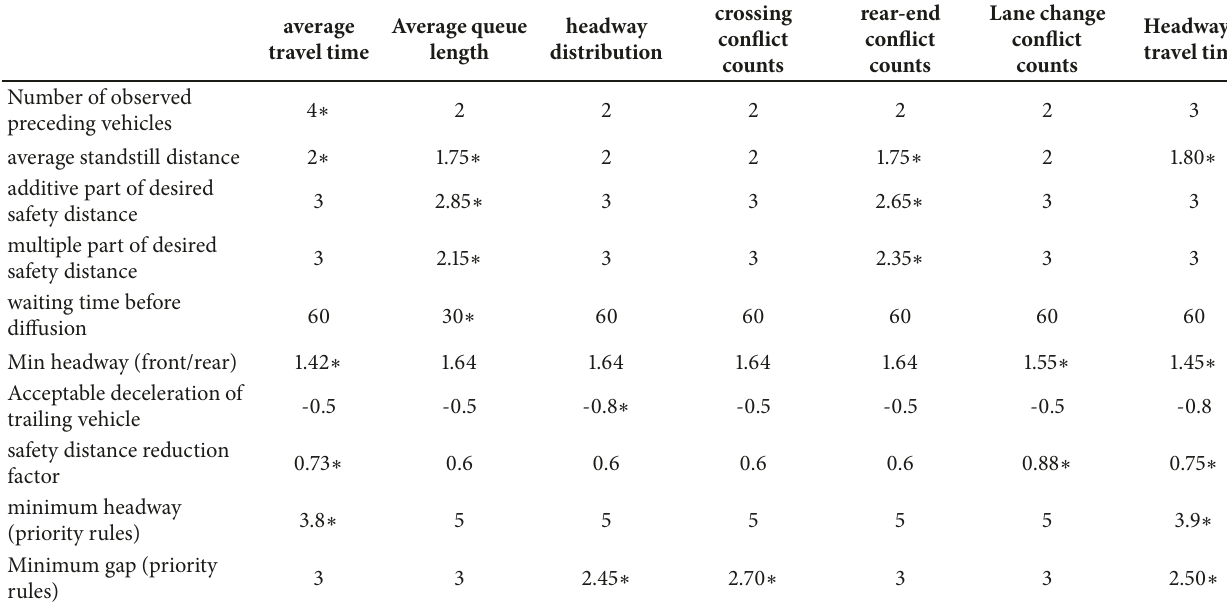
Table 3: Calibrated driving behavior parameters for testing